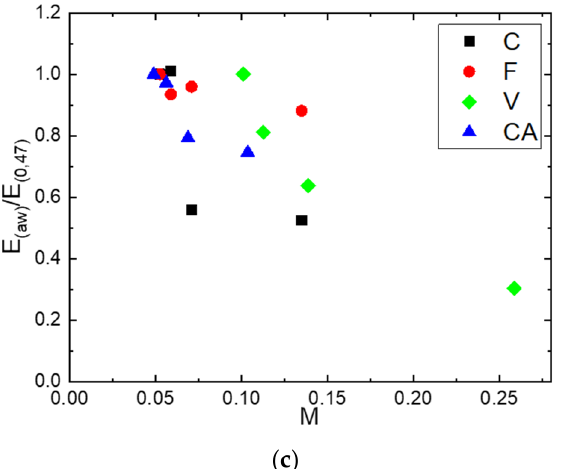
Figure 10. Evolutions as a function of the water mass gain of: ( a ) the normalized breaking stress ( σ a / σ 0.47 ) , ( b ) normalized deformation at break ( ε a (cid:3298) w